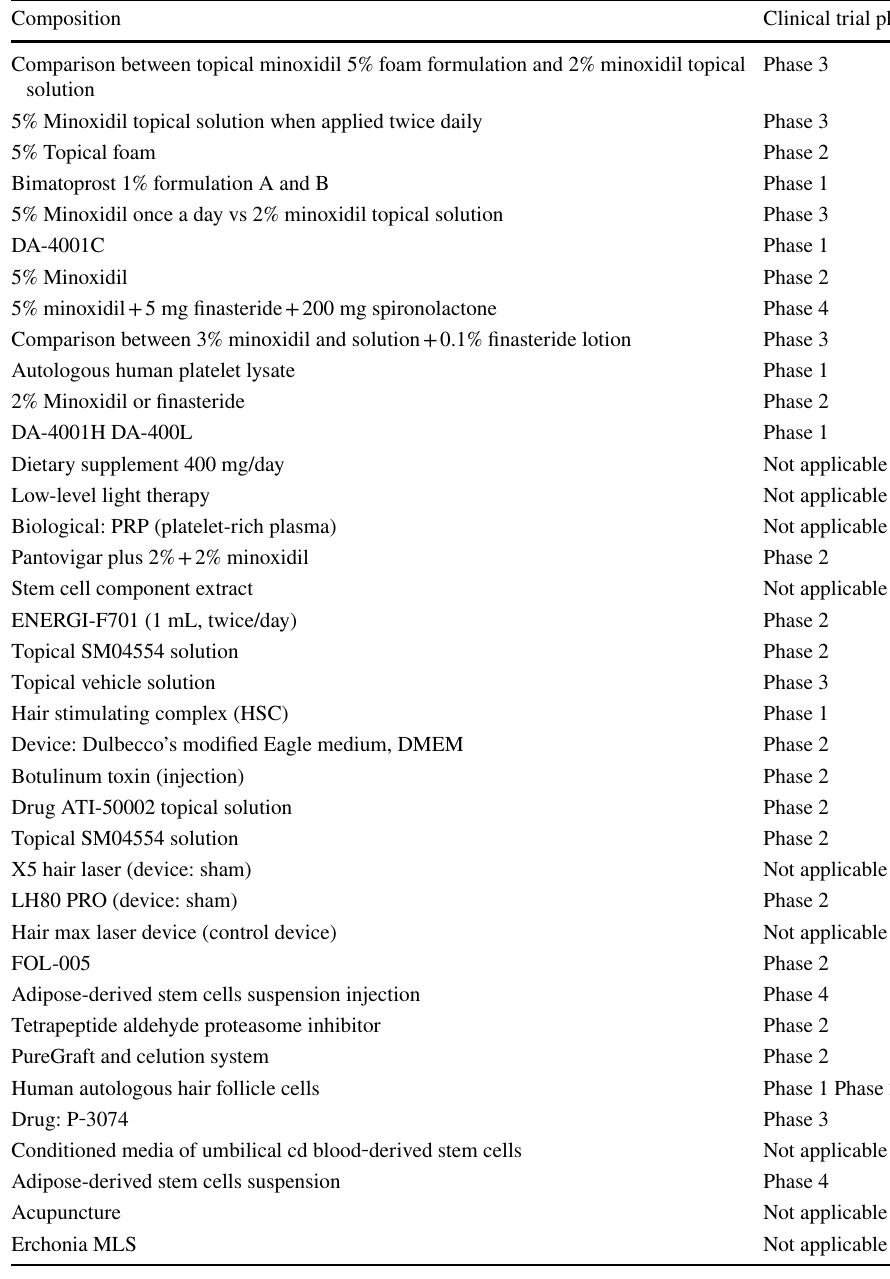
Table 16 Formulation under clinical